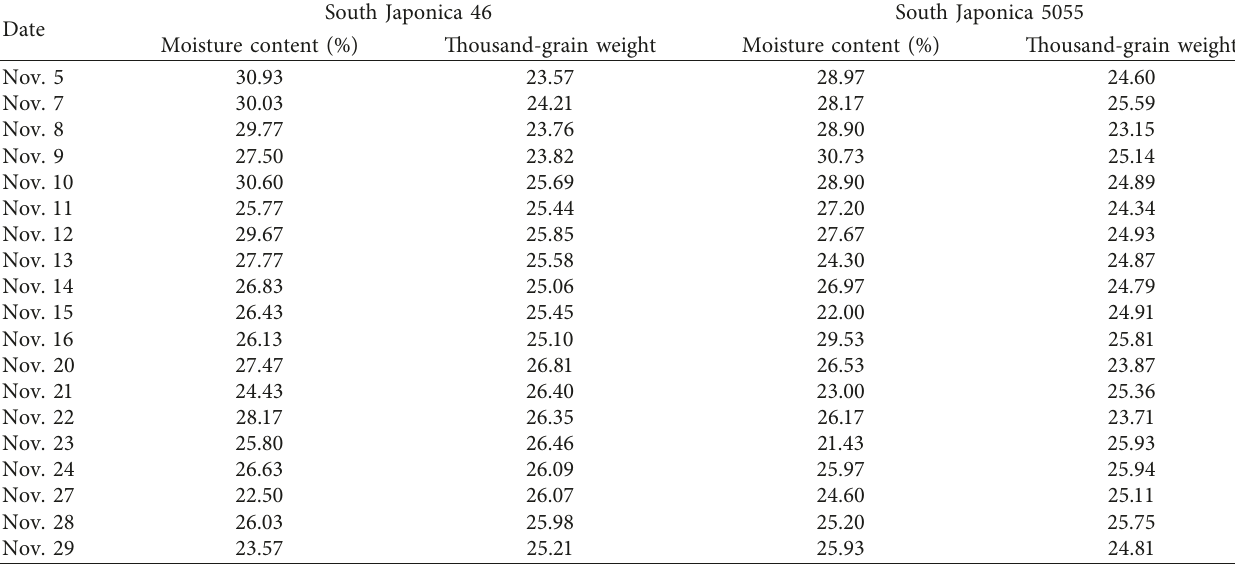
Table 2: Grain moisture content and thousand-grain weight of two experimental varieties during the trial